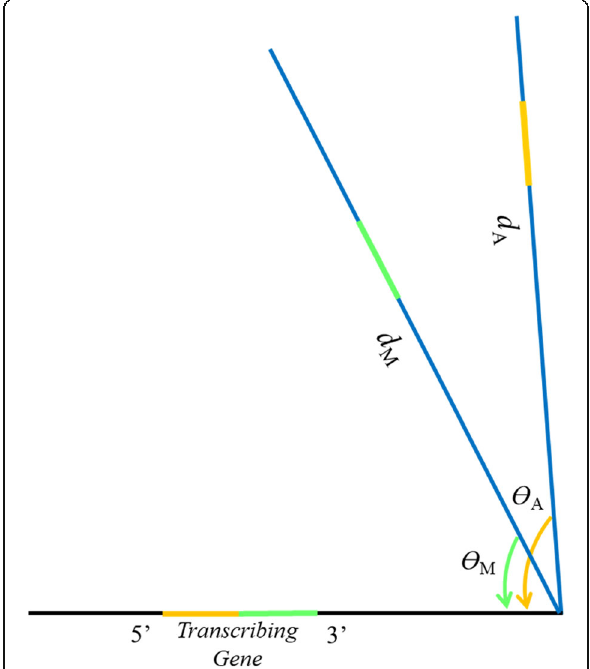
Fig. 1 Angulation of intergene base arc distance tropy in reference to the z , x -axis horizontal plane for amorphous heterochromatin loop segment genes. Amorphous heterochromatin strand loop micro-structural segmentation is a series of intergene base distance- separated alternating anisotropic (a) and mesotropic genes (m) in the form of one or two in-tandem anisotropic or mesotropic genes of the same at angulation ( Θ A , Θ M ) in the z , y -vertical axis plane. The prelamin-A/C gene ( P eff , 0.184)-containing amorphous form heterochromatin strand loop segment for example is arranged as LMNA ( Θ A = 67.8 0 )- SEMA4A ( Θ A = 73.7 0 )- SLC25A44 ( Θ M = 42.3 0 )- PMF1- BGLAP ( Θ A = 72.4 0 )- TMEM79 ( Θ A = 64.4 0 )- TSACC ( Θ M = 49.4 0 )- RHBG ( Θ M = 55.3 0 ) in series from 5 ’ to 3 ’ on human ch 1q22 at positions +1 through +6 in reference to LMNA . As shown is an anisotropic gene within its hypotenusal gene intergene base distance tropy positioned at angulation, Θ A ≤ 82.3 0 in the z , y -vertical plane with Σ gene + intergene base distance, d A · sin Θ A , juxtaposed to a mesotropic gene within its hypotenusal gene intergene base distance tropy positioned at angulation, Θ M ≥ 11.7 0 , from the horizontal line of unity in a heterochromatin strand amorphous form loop segment. A transcribable gene can be either an anisotropic segment loop gene ( Θ A ) or a mesotropic gene segment loop gene ( Θ M ) in an amorphous segment loop of alternating in-tandem genes. Legend. d A , hypotenusal distance of anisotropic gene intergene tropy bases; d M , hypotenusal distance of mesotropic gene intergene tropy bases. Note: 3 ’ ,